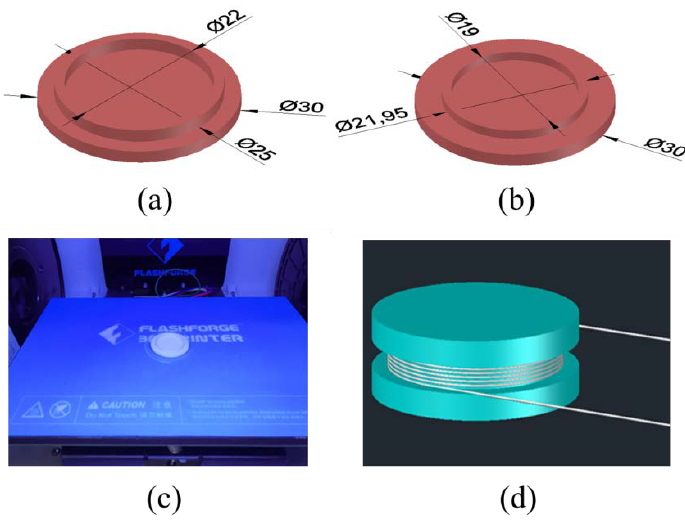
Figure 1. Diagram of ( a ) the external and ( b ) internal component of the cylindrical elastomer; ( c ) the 3D printing process of the cylindrical elastomer; and ( d ) the sensing element spooling with optical